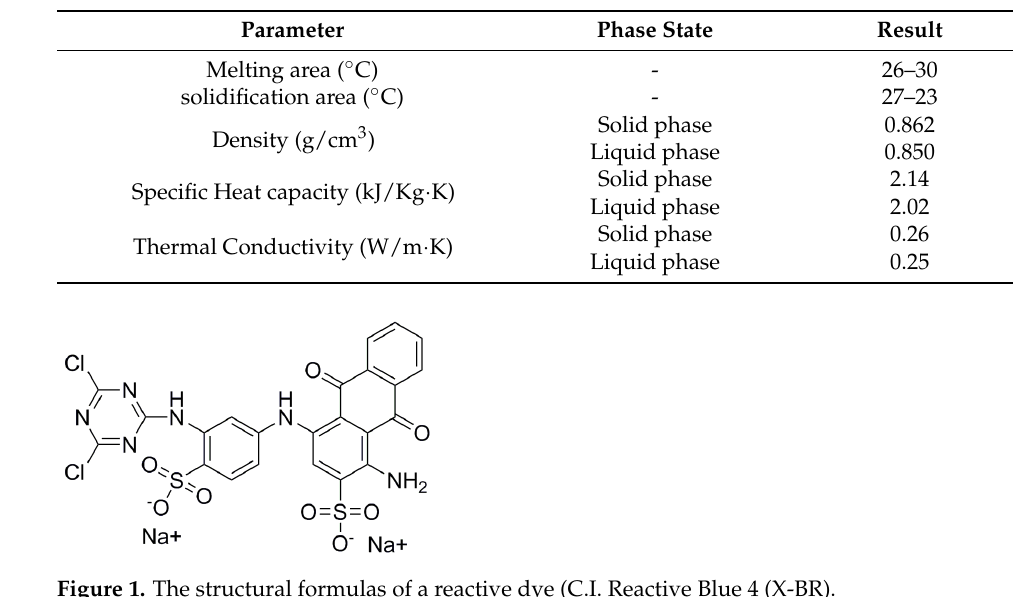
Table 1. Properties of paraffin RT28HC used for research.